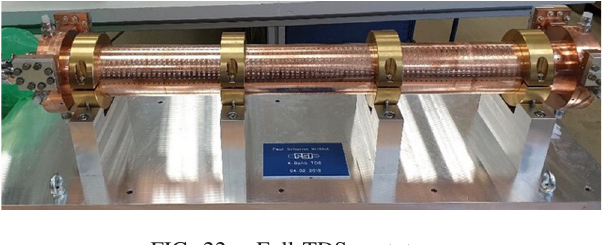
FIG. 22. Full TDS prototype.